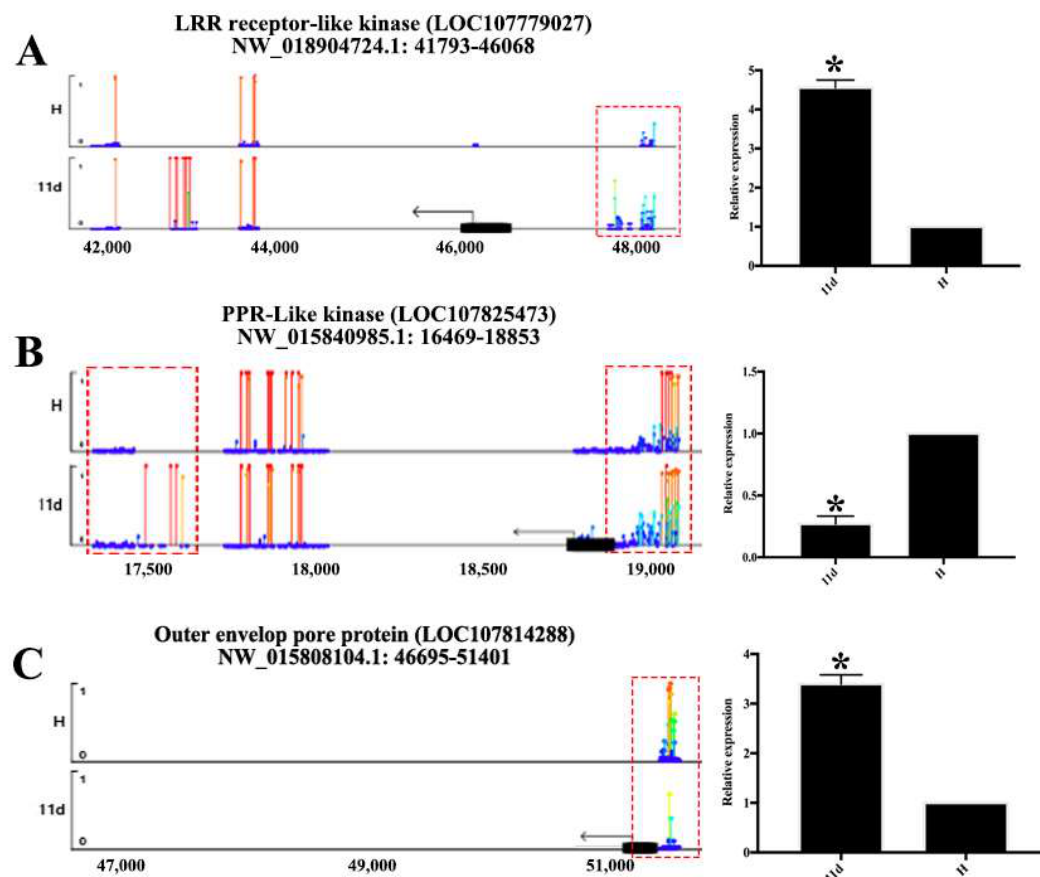
Figure 4. Methylation level across the nucleotides of the gene body and promoters of LRR receptor-like kinase ( A ); PPR-like kinase ( B ) and outer envelope pore protein ( C ). Dark lines and arrows showed the transcription direction and the start of gene body and to the right of them were promoter regions. Red box means significant changes in methylation level. The lollipop line (Y-axis) showed the methylation level. Expression levels are shown on the right of each figure. Expression levels are shown on the right. Significant differences are indicated (* p < 0.05) based on Student’s t -test.